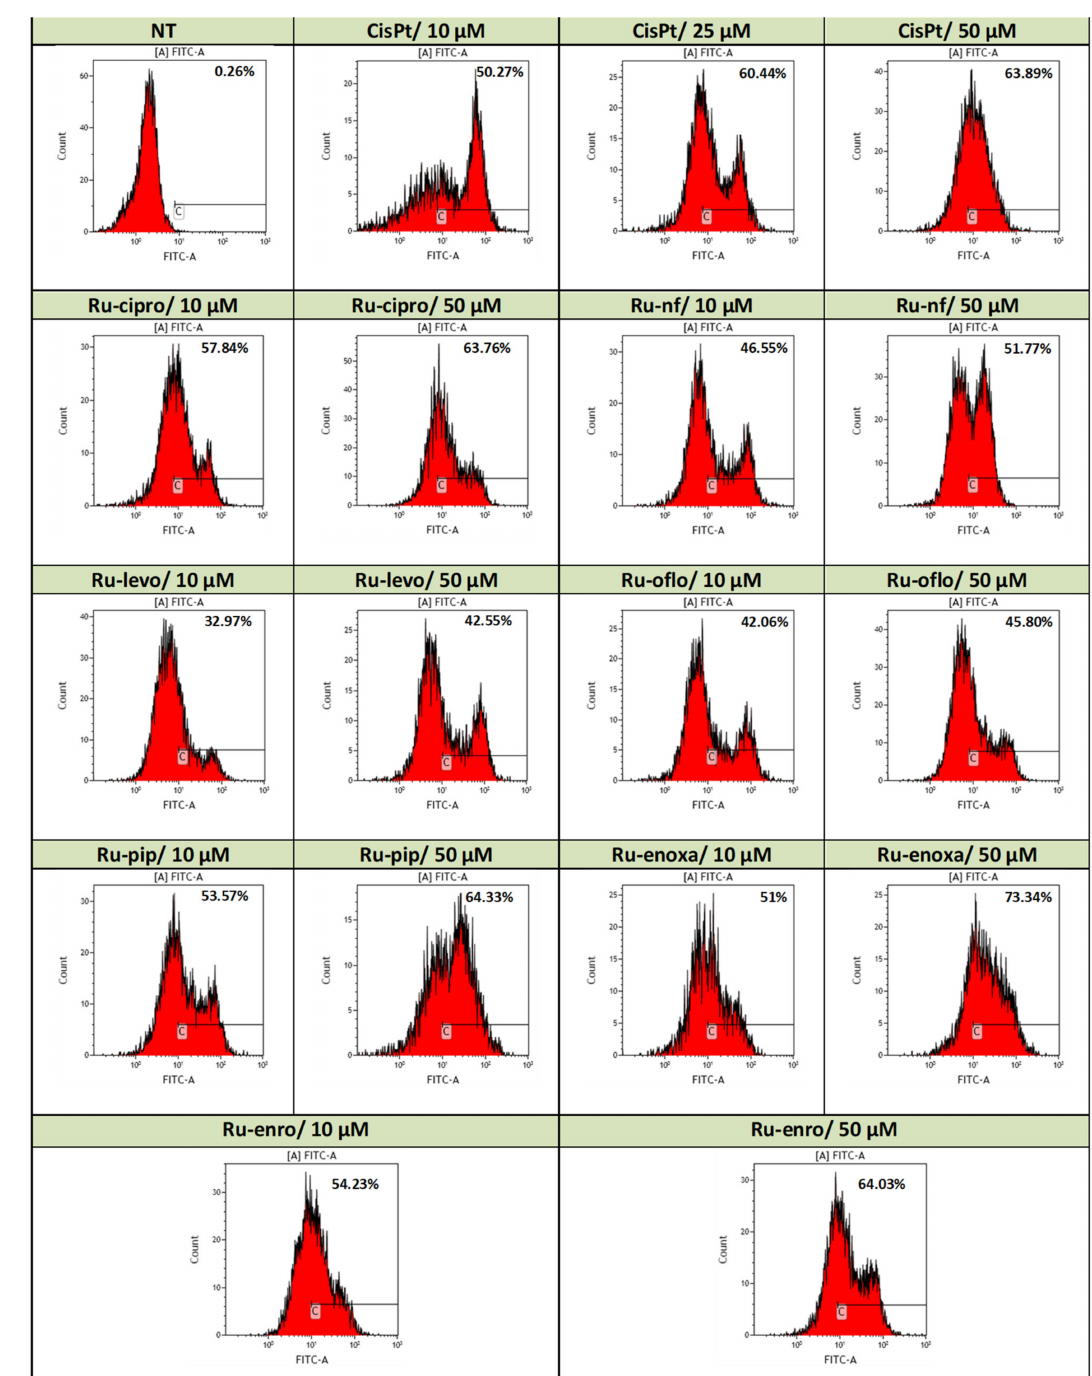
Figure 4. Induction of apoptosis in the LoVo cell line by Ru(III) complexes vs. CisPt. Effects of drug treatments on apoptosis induction in the LoVo human colon adenocarcinoma cell line were evaluated by Annexin-V/FITC and PI double-staining assay. Levels of apoptotic events were assessed by flow cytometry acquisition using a FACScan cytometer and analysis with WinMDI2.9 and Kaluza softwares. Data are presented as flow cytometry